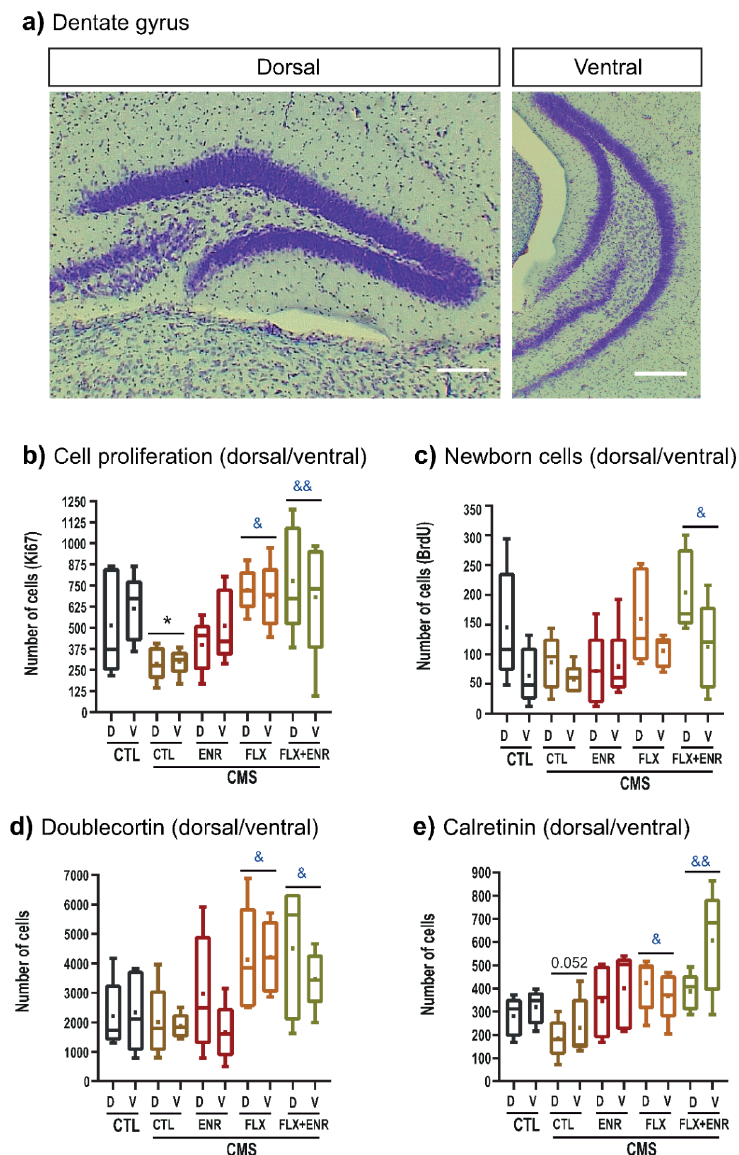
Figure 4. Distribution of cellular populations along the dorsal–ventral hippocampus. ( a ) Representative images after Nissl staining show dorsal (left) or ventral (right) hippocampus. Scale bars represent 100 µm. Chronic mild stress (CMS) decreases hippocampal neurogenesis (CTL-CMS) compared with unstressed mice (CTL). Environmental enrichment (ENR), fluoxetine (FLX), or their combination (FLX + ENR) reverses the decreased neurogenesis caused by chronic stress. ( b – e ) Distribution of cellular populations involved in the neurogenic process along the dorsal–ventral (D, V) hippocampus. Similar results were found in Ki67 ( a ), newborn cells ( b ), doublecortin ( c ) and calretinin ( d ) cells. Symbols “&, &&” or “*” in (a, d) indicate p ≤ 0.05.